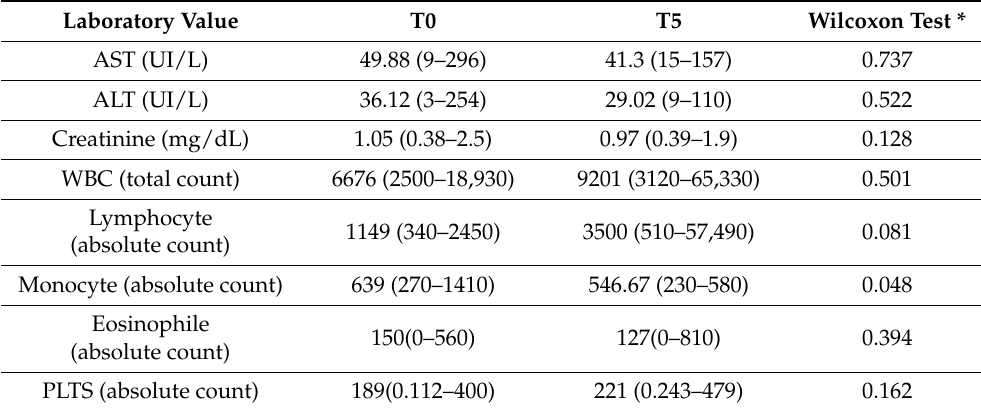
Table 2. Laboratory values changes between Time from Day 0 (T0) and Time from Day Five (T5) in patients treated with